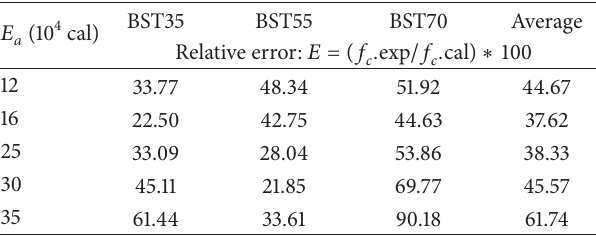
Table 4: Relative error of simulation of strength development of heat treated (at different temperature) sand concrete using several values of apparent energy of